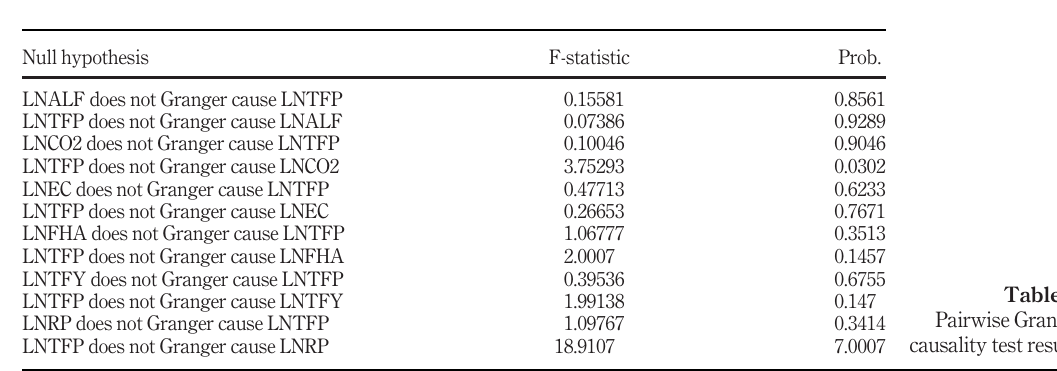
Figure 2. Cumulative sum of squares of